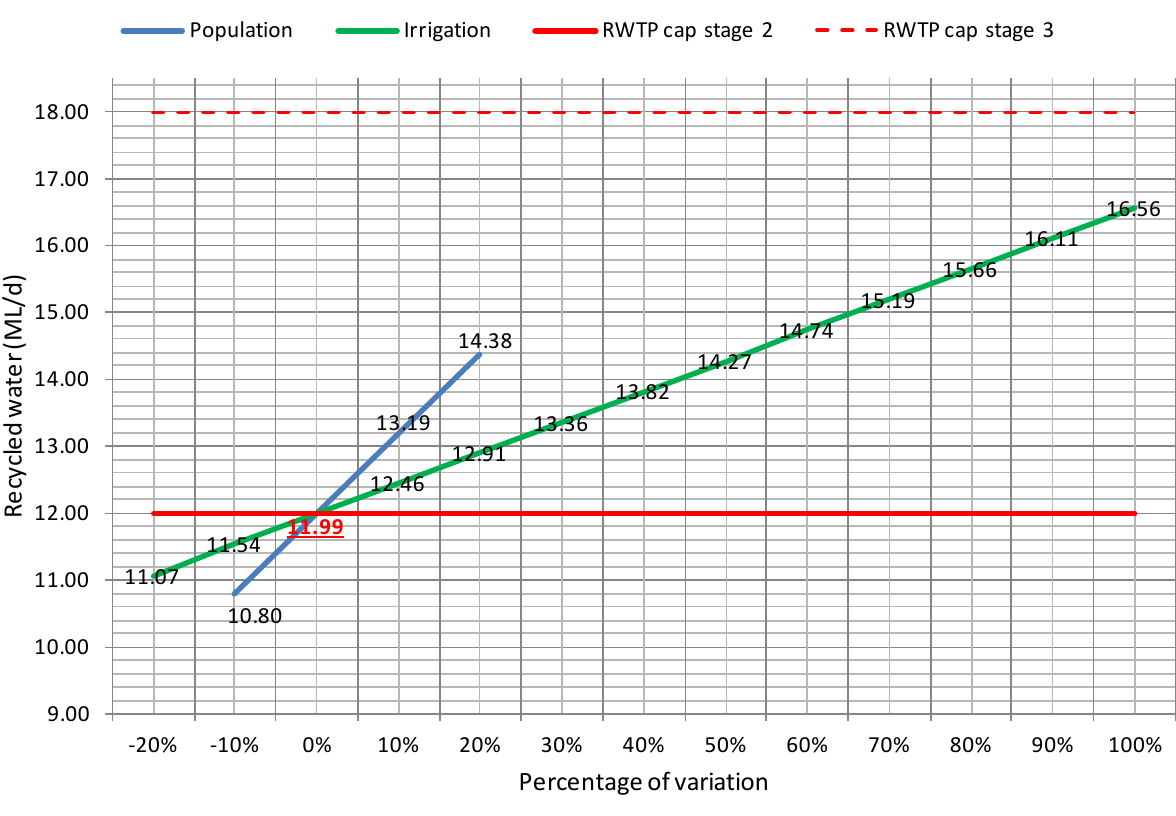
Figure 5 . Spider graph for current scheme demand prediction in 2056 (peak factor =